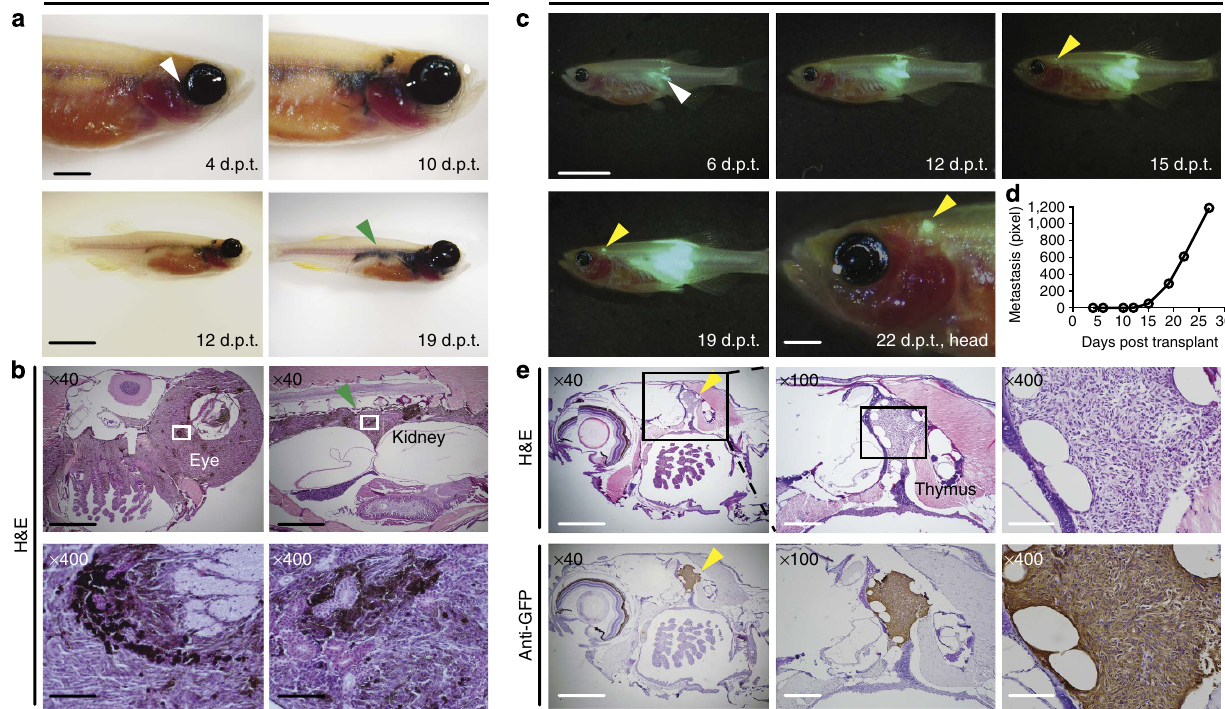
Figure 5 | Visualizing melanoma invasion and metastasis following engraftment into rag2 E450fs (casper) mutant fish. ( a ) Invasion assays using retro- orbital transplantation of a BRAF V600E , tp53 (cid:2) / (cid:2) pigmented melanoma. White arrow denotes the site of injection. Green arrow denotes spread to the kidney marrow that is contiguous with primary tumour growth that has arisen adjacent to the eye. Histological examination confirmed the presence of pigmented melanoma cells at the site of injection ( b , left panels) and contiguous with the trunk kidney ( b , right panels). ( c ) Metastasis assays using implantation of non-pigmented, GFP-labelled melanoma cells into the dorsal musculature of rag2 E450fs (casper)- recipient fish. White arrow denotes the site of injection. Yellow arrow denotes site of distal metastasis. ( d ) Quantification of metastatic growth as assessed by epi-fluorescence microscopy over time. ( e ) Haematoxylin and eosin-stained sections of the same animal imaged in c , confirming metastatic growth of melanoma adjacent to the thymus (top panels) and confirmed by anti-GFP immunostaining on section (bottom panels). Scale bars equal 5mm for whole animal images, 2mm in images of heads, 1mm in (cid:3) 40 histological images; 300 m m in (cid:3) 100 histological images and 100 m m in (cid:3) 400 histological